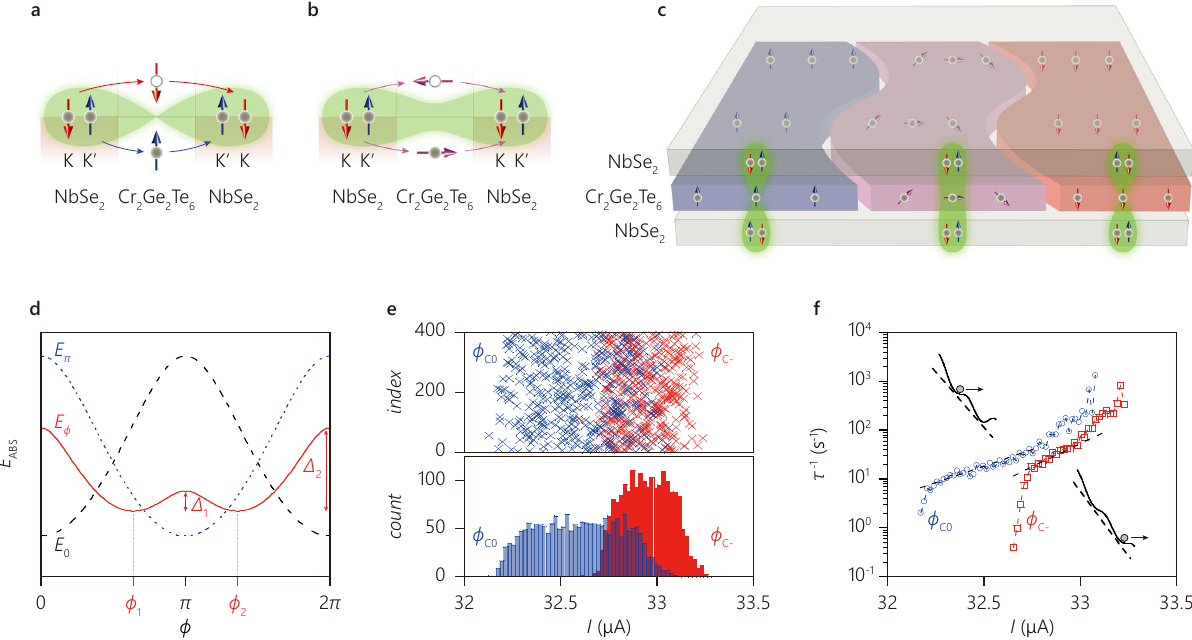
Fig. 4 Ising-Cooper-pair coupling through the all-crystalline vdW magnetic Josephson junction. a – c Illustration of the Ising-Cooper-pair coupling through the magnetic tunneling junction for perpendicular magnetization ( a ), for in-plane magnetization ( b ), and for magnetic structure ( c ). For perpendicular magnetization, Ising Cooper pairs can tunnel via the spin-dependent energy levels without spin fl ip, forming a π -phase junction. For in-plane magnetization, tunneling occurs with a spin fl ip, which requires zero phase. With the magnetic domain structure of Cr 2 Ge 2 Te 6 , the Josephson junction consists of segments of π - and 0-phases. d Washboard potential for the ϕ junction (indicated by solid red line), zero junction (dashed black line), and π junction (dotted blue line). Nontrivial Josephson phase ϕ 1 and ϕ 2 appear as the minimum energy for ϕ state (the red line is calculated using λ = 0.53 and D = 0.75). e , f switching current distribution for the ϕ state at T = 1.1 K. Different switching current is repeatedly acquired with different sweeping, as depicted in Fig. 3d. The lower and higher critical currents are depicted in blue and red. e Switching currents with different sweeping events (top panel) and histogram of switching currents in 0.02 μ A bins (bottom panel). f Escape rate τ − 1 as a function of the bias current that has a different slope (corresponding to an energy higher than the environment temperature) re fl ected by the different metastable states of the tilted washboard potential shown in ( d ), and the potential barrier for each escaping event is schematically illustrated in the insets. The dashed lines are guide to